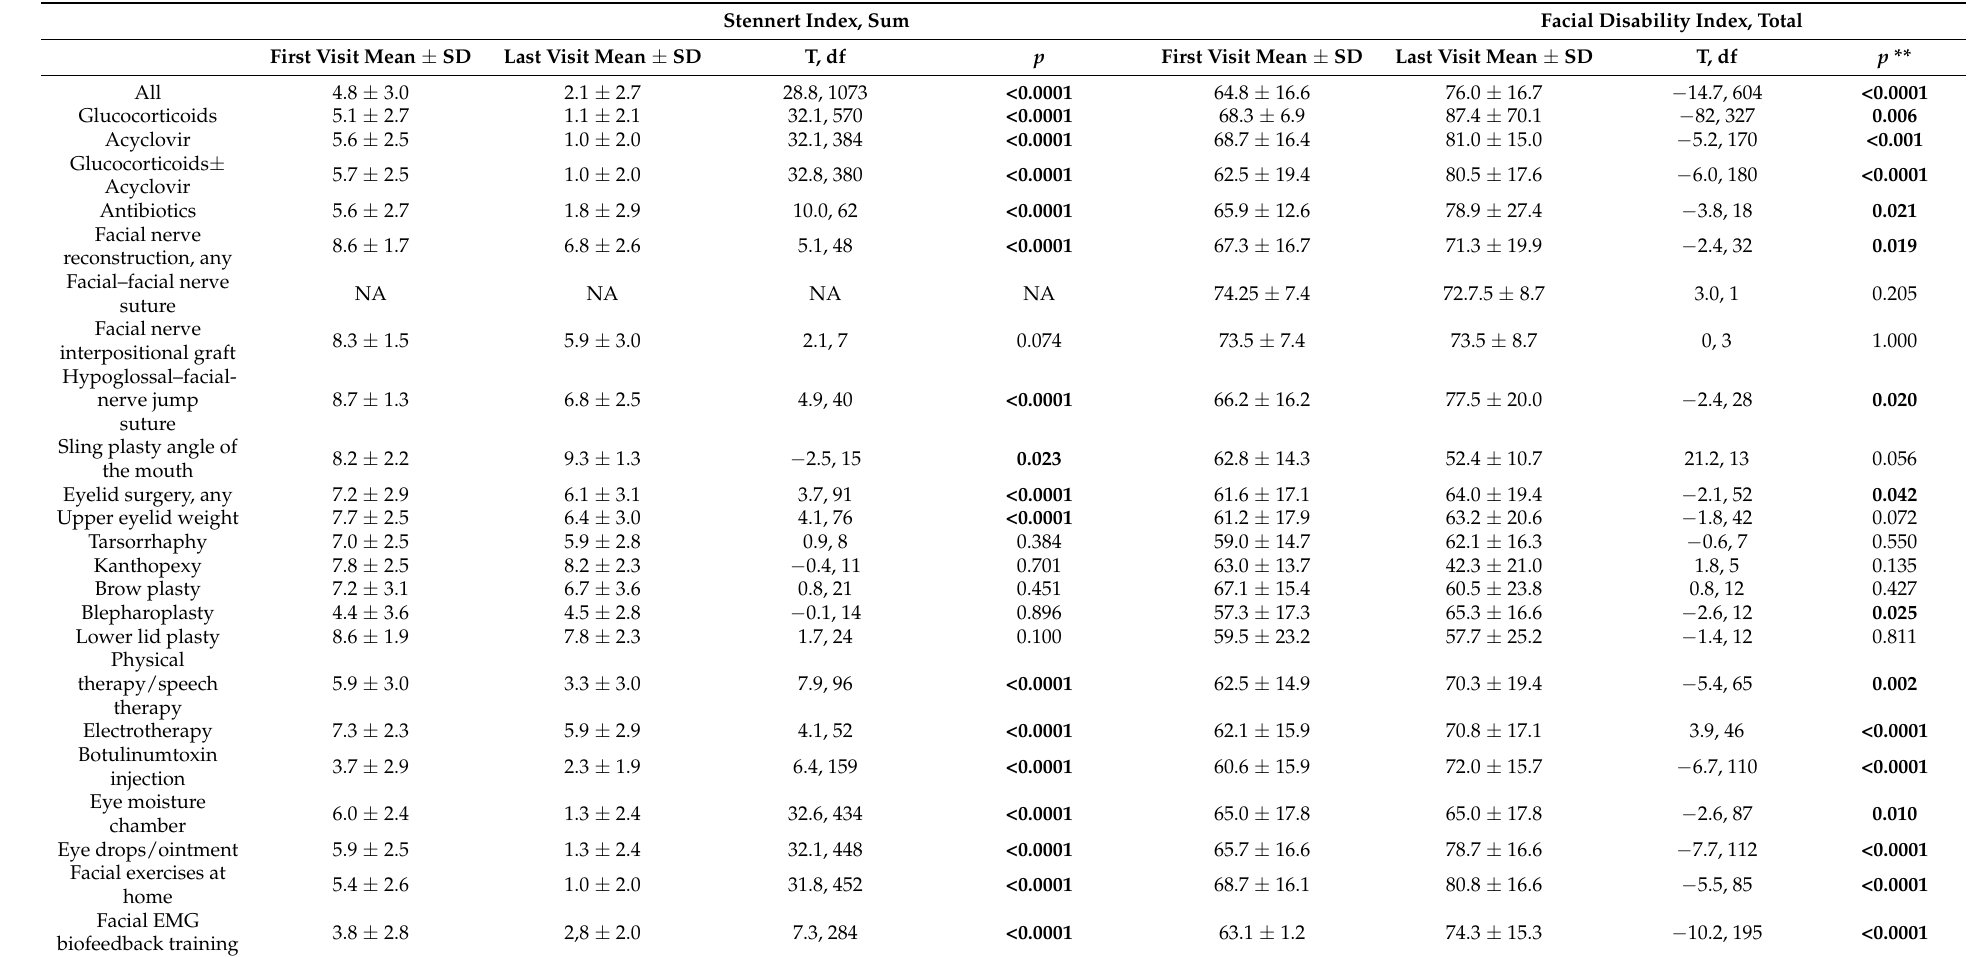
Table 6. Comparison of outcome measures using the Stennert index (sum) and the Facial Disability index (total) between first and last visits *. Stennert Index, Sum Facial Disability Index,